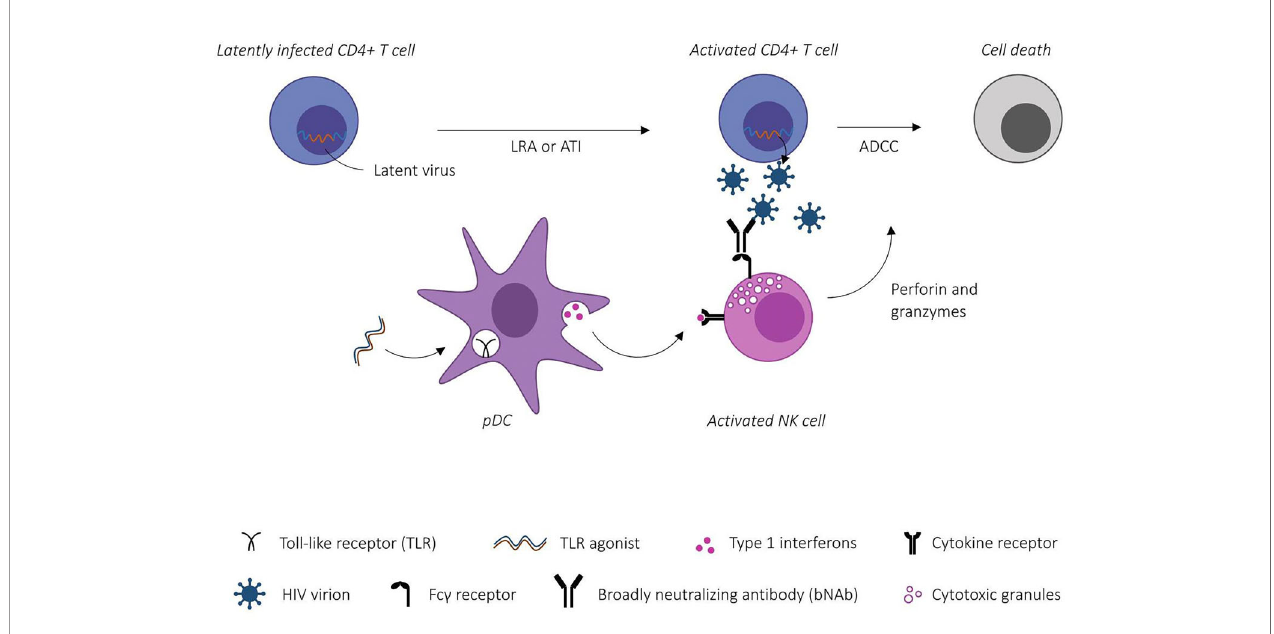
FIGURE 1 | Schematic illustration of Toll-like receptor (TLR)-agonist mediated enhancement of antibody-dependent cellular cytotoxicity (ADCC). TLR-agonists prime the innate immune system through plasmacytoid dendritic cell (pDC) activation. Activated effector cells (here NK cells) bind broadly neutralizing antibody-antigen complexes via Fc g receptors inducing ADCC-mediated killing of HIV-1 infected CD4+ T cells. [Modi fi ed from Martinsen et al.